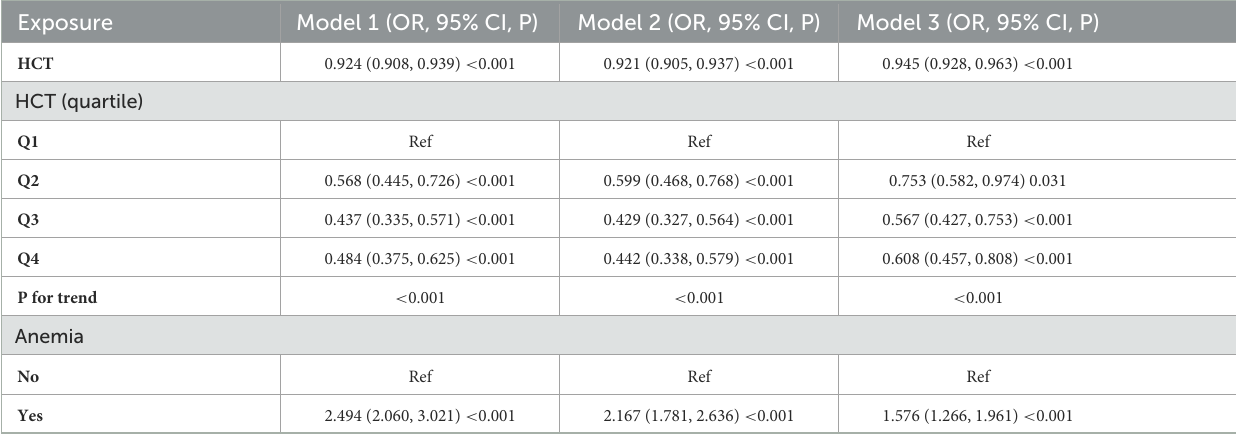
TABLE 2 Relationship between preoperative HCT and 30-day postoperative mortality in the three binary logistic regression models.